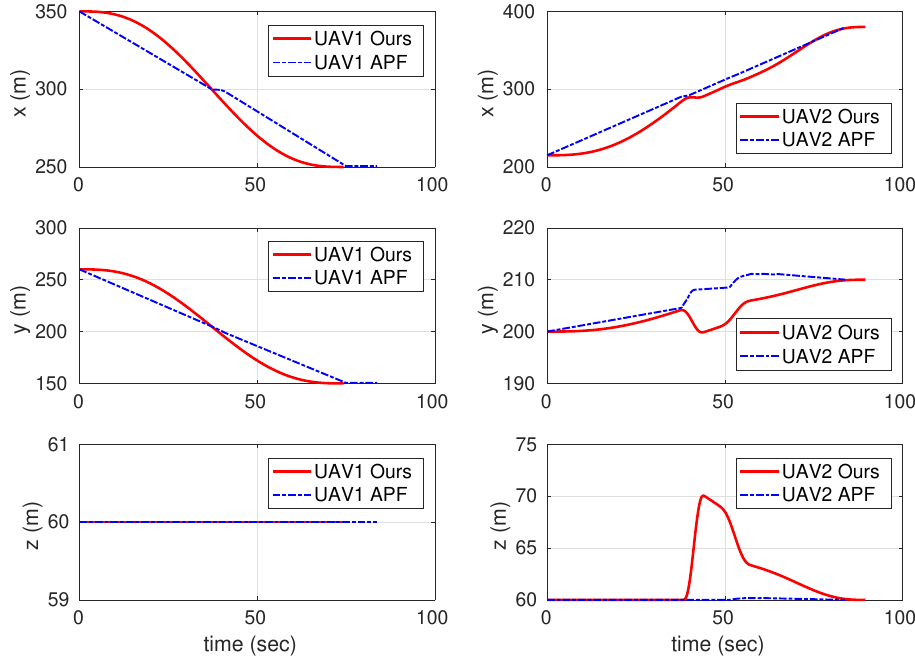
Figure 19. Position of the complex environment